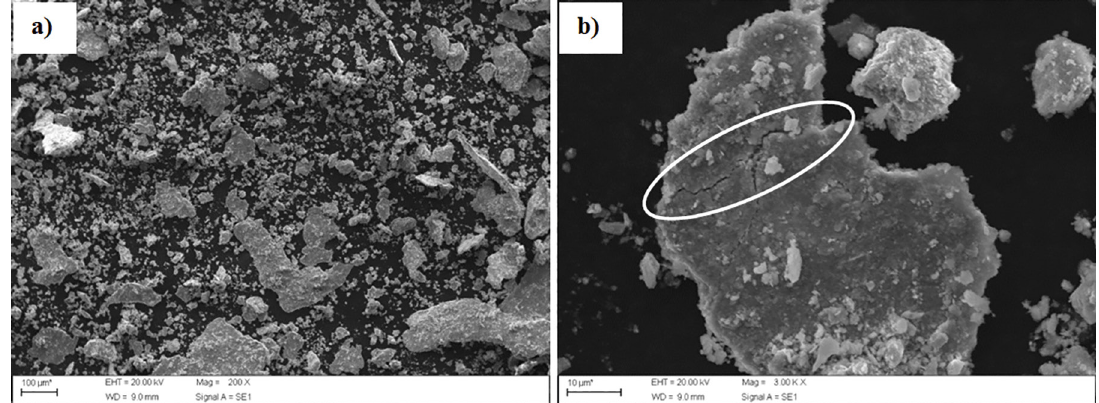
Figure 5. Aluminum bronze alloy milled for 70 hours in form of powders (a); particle fracture due to the milling process (b).